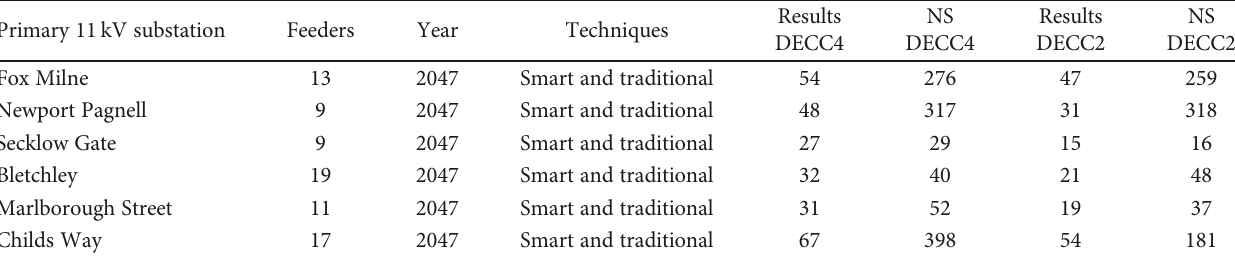
Figure 21: Parallel coordinate visualisation of technoeconomic performance indicators under DECC4 and DECC2. Table 4: Summary of network states and results for demand scenario; DECC4 and